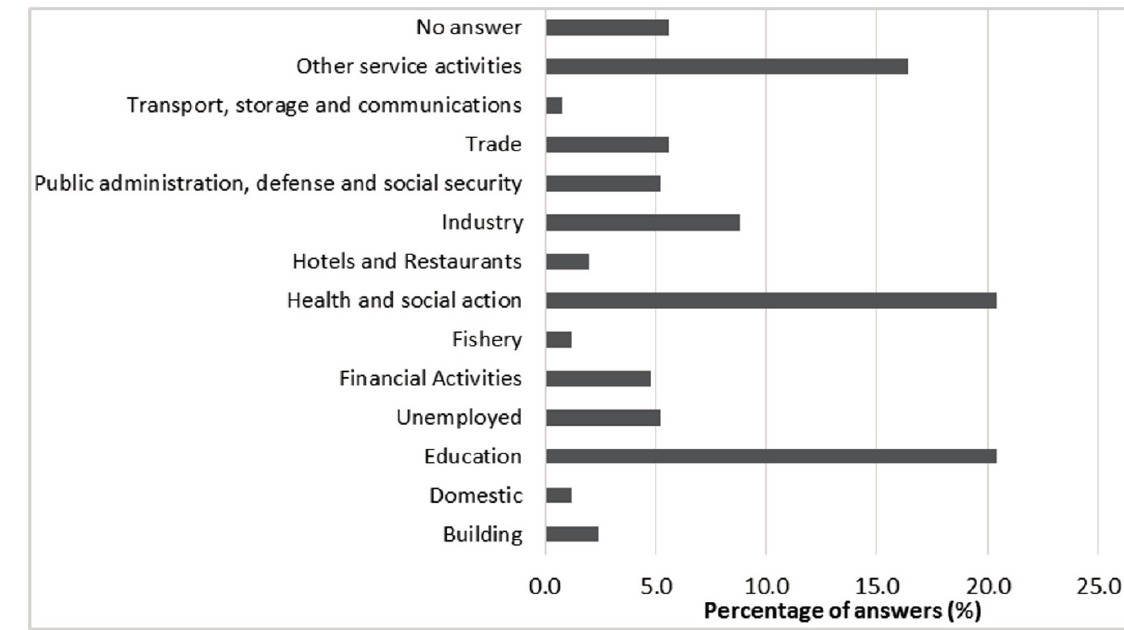
Figure 4. Caregivers’ professional